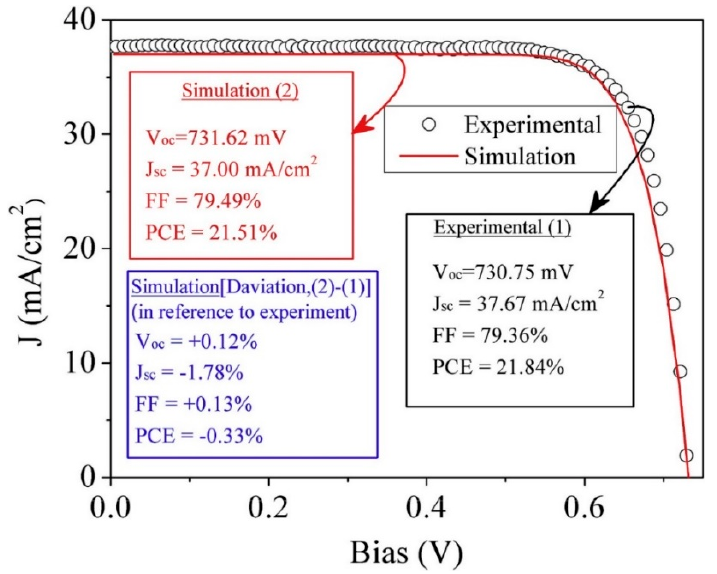
Figure 8. The J-V characteristic plots of a simulated and experimental solar cell (reprinted with permission from ref. [98]; copyright form Elsevier order number 5492920955733).